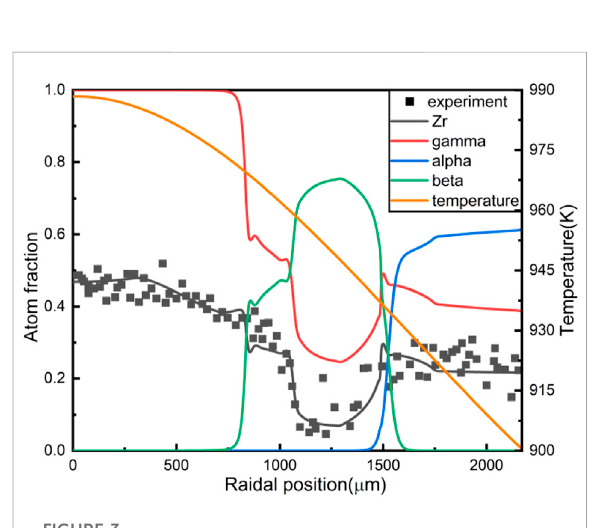
FIGURE 3 The results of U-10wt%Zr constituent redistribution with introducing the radiation-enhanced diffusion. FIGURE 4